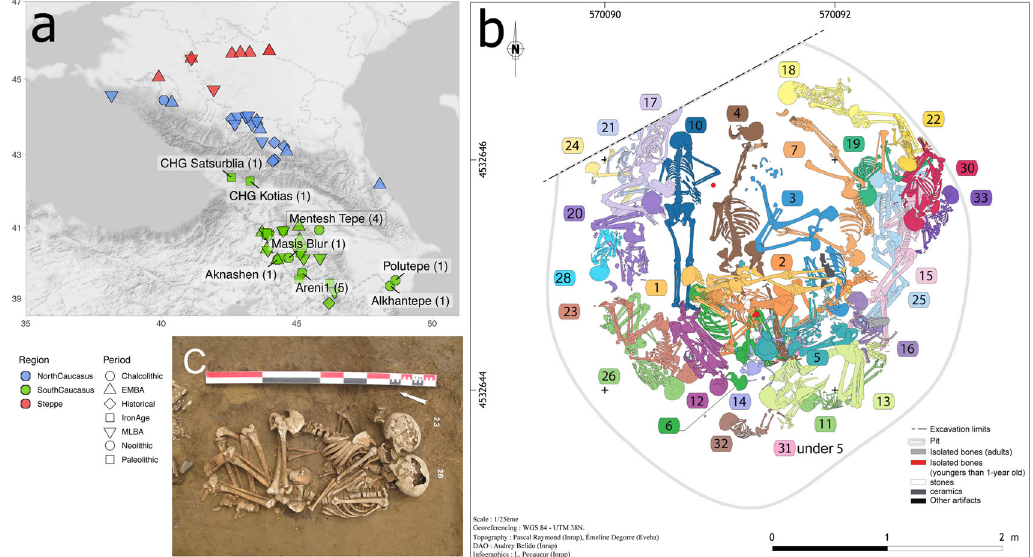
Fig. 1 Mentesh Tepe. a Localisation of Mentesh Tepe and other Neolithic and Protohistoric places that provided ancient genomes. Map tiles by Stamen Design, under CC BY 3.0. Data by OpenStreetMap, under ODbL. b Structure 342 and localisation of each individual. c Photograph of MT23 and MT26 (credit L.